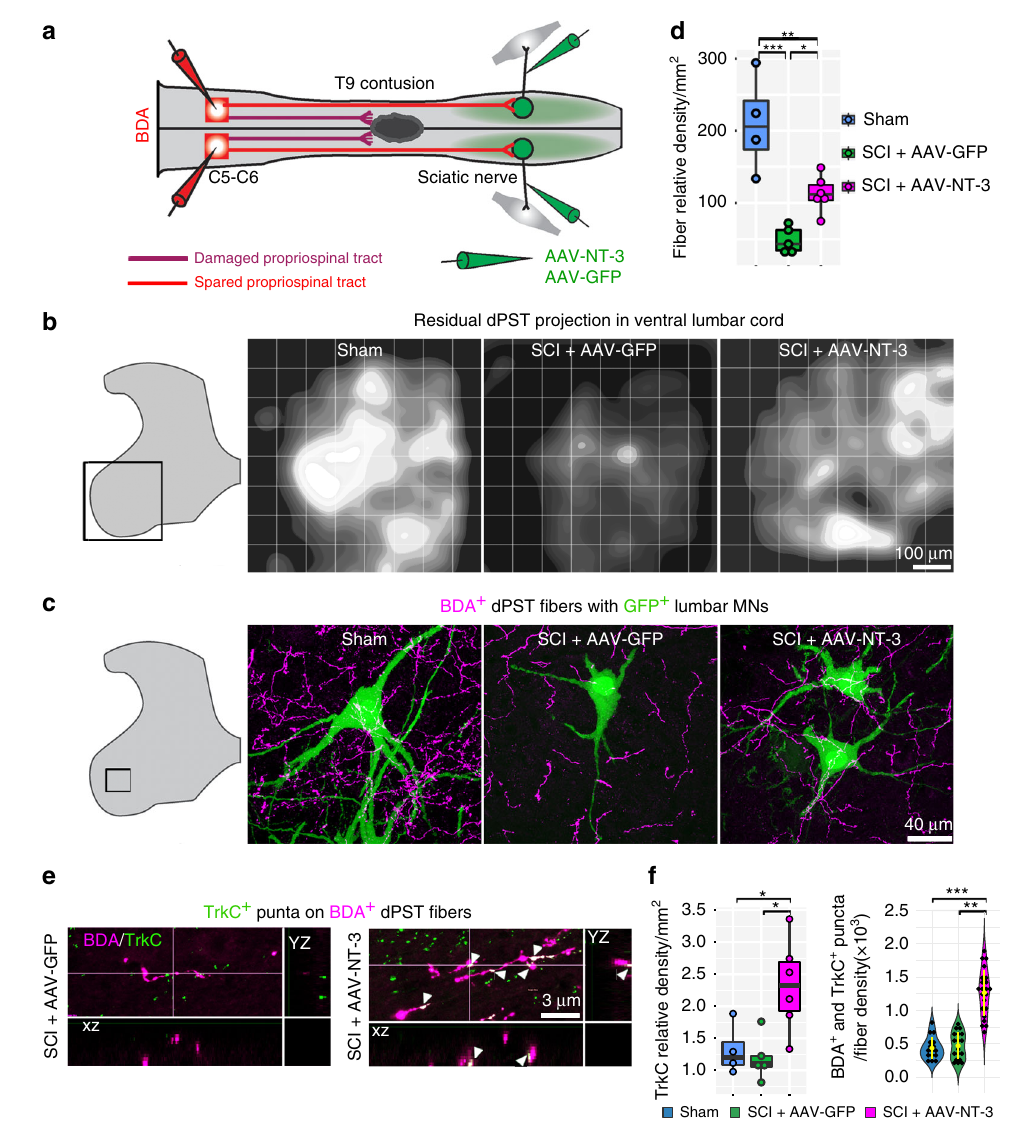
Fig. 3 Residual dPST responded to NT-3 by increasing its terminal sprouting and TrkC expression. a Diagram illustrates BDA injections into cervical segments (C5 – C6) to label the cervical dPST axons projecting to the lumbar spinal cord following the T9 contusion. b Representative black-to-white intensity scales demonstrating residual dPST axonal distribution in the ventral horn of the lumbar spinal cord (boxed area) after the T9 contusion in each experimental group. c Higher magni fi cation of boxed area shows close apposition of BDA + dPST axons with lumbar MNs (GFP + ), which were more frequently seen in the SCI + AAV-NT-3 group than the SCI + AAV-GFP group. Scale bar = 40 μ m. d Bar plot indicates the relative integrated density/mm 2 of BDA + dPST fi bers in the lumbar ventral horn between groups; n = 4 – 6 mice per group (3 – 5 sections per animal). e Confocal z-stacks demonstrate that TrkC was expressed in the lumbar spinal cord, with some TrkC co-localization with BDA + dPST terminals in the AAV-NT-3-treated group (arrowheads). Scale bar = 3 μ m. f Bar plot shows TrkC relative integrated density/mm 2 and individual values for each animal (3 – 5 sections per animal). Violin plot represents the ratio of double-labeled puncta (TrkC and BDA) to BDA relative integrated density in the corresponding sections. The yellow lines from the violin plots indicate mean ± SD. Data are presented as box plots with center lines indicating medians, boxes representing 25th to 75th percentiles, also known as the interquartile range (IQR), and whiskers representing data points within 1.5 times the IQR; n = 4 – 6 biologically independent animals per group. * P < 0.05; ** P < 0.01; *** P < 0.001. One-way ANOVA followed by Tukey ’ s post-hoc test. dPST descending propriospinal tract, TrkC tropomyosin receptor kinase C. Source data are provided as a Source Data fi terminals contacting lumbar MNs appeared in SCI + AAV-NT-3 virus (PRV) carrying the enhanced GFP (EGFP) was introduced than in SCI + AAV-GFP groups (Fig. 3c, d, Supplementary to retrogradely label the lumbar MN-related interneurons above, Fig. 4e, f). Importantly, AAV-NT-3 treatment signi fi cantly at, and below the lesion (Supplementary Fig. 5a). PRV labels enhanced TrkC (a highly selective receptor for NT-3) expression different-order neurons in a time-dependent manner 25 . There- fore, we fi rst detected PRV-labeled lumbar MNs at 24 h post- in the gray matter of lumbar spinal cord and accordingly elevated injection (Supplementary Fig. 5b). At 72 h, viral propagation is TrkC-BDA colocalization along with BDA-labeled dPST axons, as suf fi cient to identify the distribution of dPNs as we observed compared to AAV-GFP-treated controls (Fig. 3e, f). PRV-labeled interneurons located in the cervical level (Supple- To con fi rm the NT-3-mediated propriospino-MN circuit mentary Fig. 5c). In sham mice with PRV injection, GFP-positive reorganization, a retrograde multi-transsynaptic pseudorabies